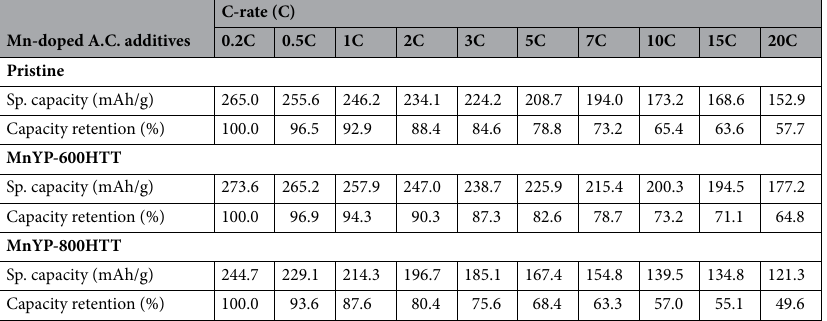
Table 4. Rate capability property of Pristine, Mn-doped MnYP-600HTT and MnYP-800HTT under different